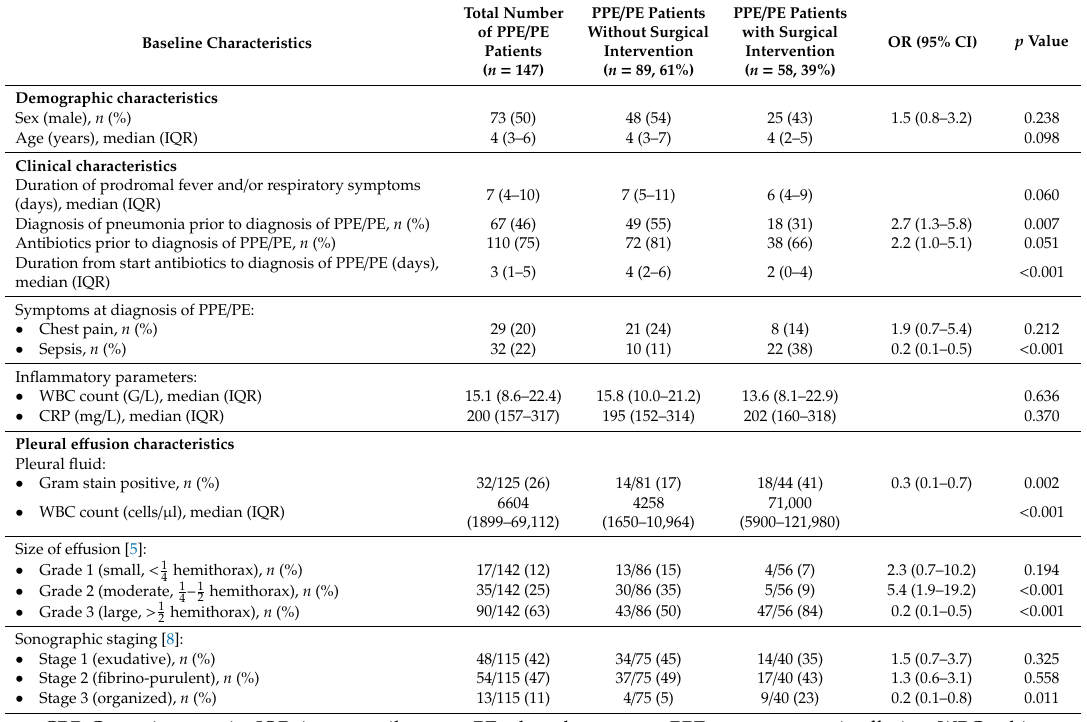
Total Number of PPE /